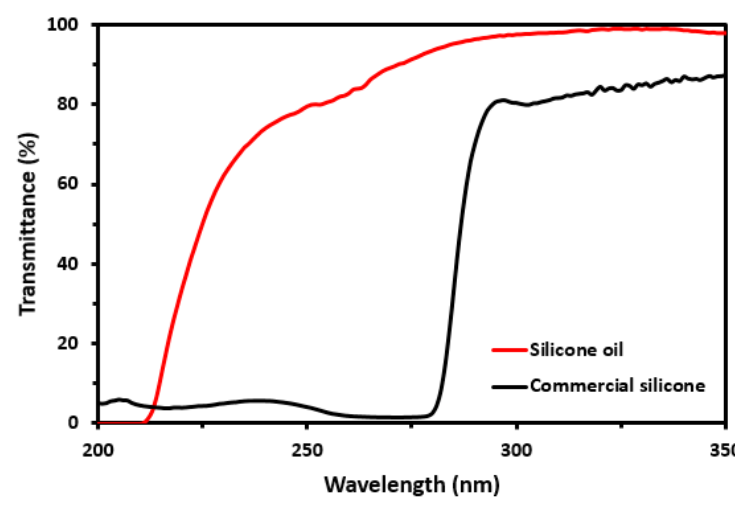
Figure 2. Transmittance of silicone oil.